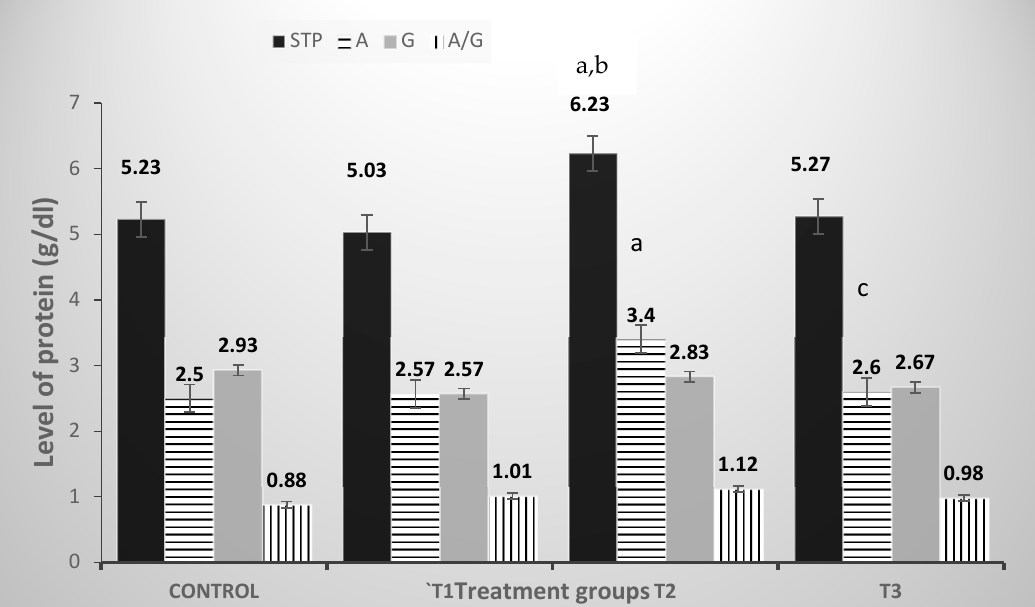
Figure 4 . Effect of pomegranate peel and garlic powder separately or in combination on serum total protein (STP) of does . Data are presented as mean ± SE (n = 5 litters). T1; pomegranate peel 3%, T2; Garlic 3%, and T3; pomegranate peel 1.5% + garlic 1.5%. STP; serum total protein, A; albumin, G; globulin, A/G; albumin/globulin ratio. a Significant difference as compared to control, b significant differences as compared to T1, and c significant differences as compared to T2 ( p < 0.05). Whereas results of liver function enzymes showed that AST activity significantly in- creased ( p < 0.05) in the PP 1.5% + GP 1.5% group than in other groups. However, rabbits fed with PP 3% or PP 1.5% + GP 1.5% showed a significant increase in ALT activity by about 1.23-fold and 1.43-fold, respectively, as compared to the control group (Figure 5).